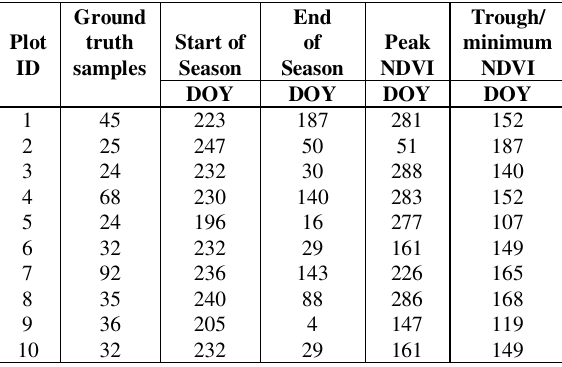
Table 1. Within field variations in citrus crop growth stage parameters